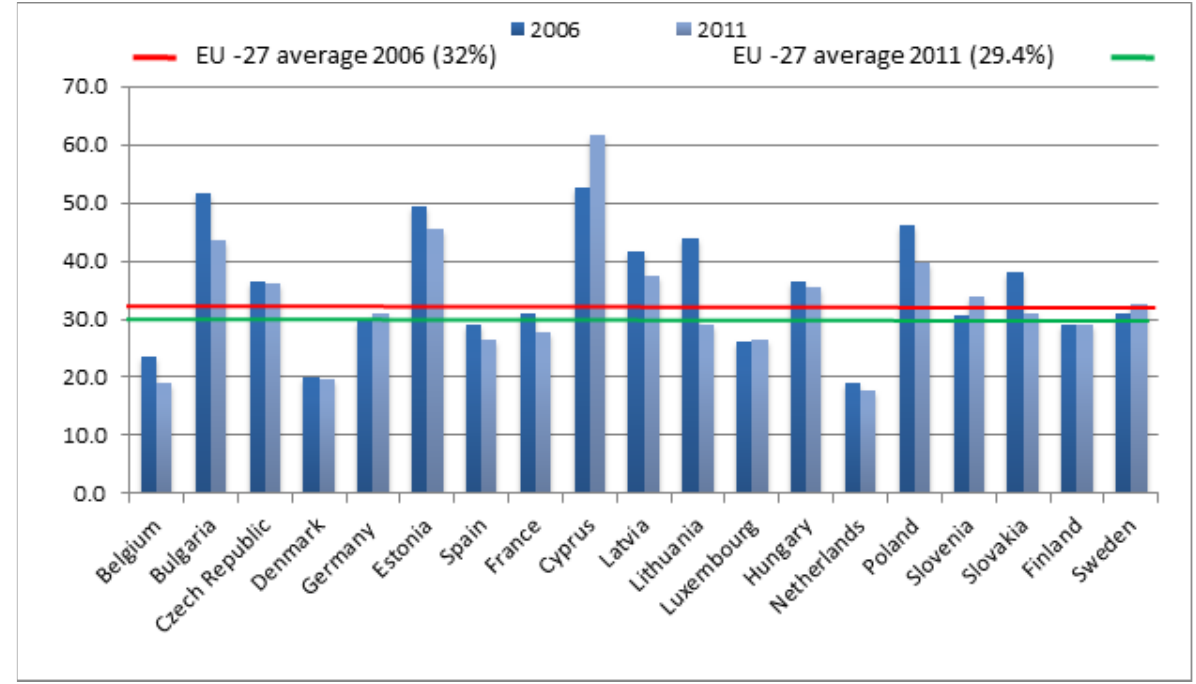
Figure 2. Percentage of VET graduates in STEM subjects in 2006 and 2011. Source: CEDEFOP 2014.